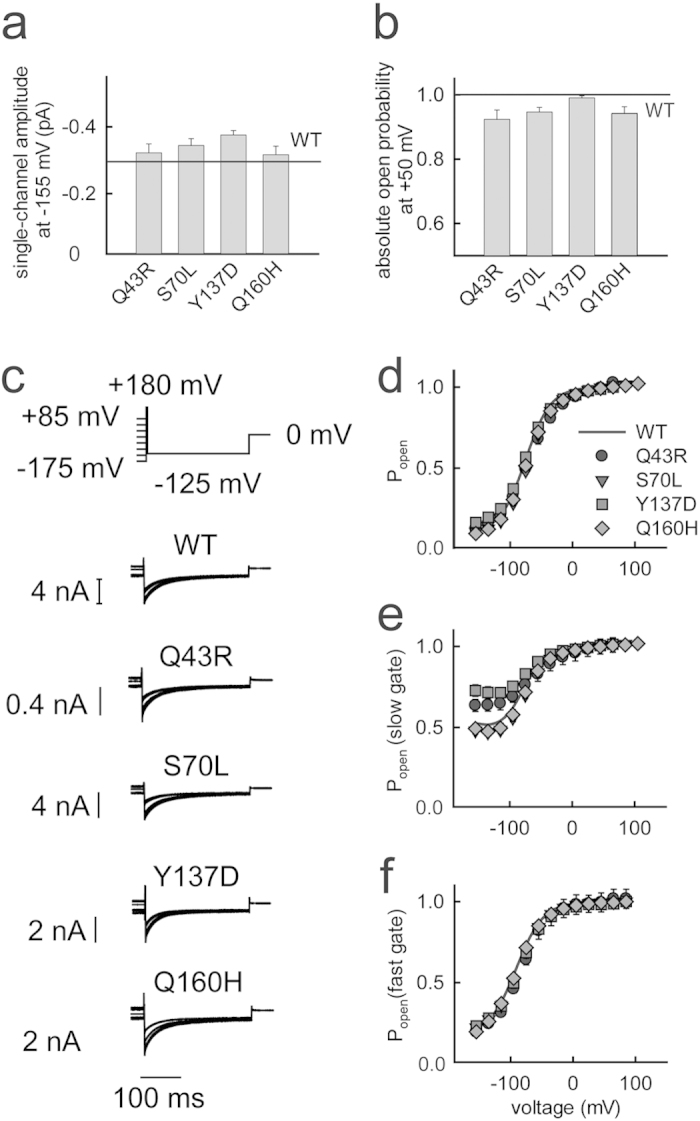
Functional properties of homodimeric mutant channels.(a,b) Mean single-channel current amplitudes at −155 mV (a) and absolute open probabilities at +55 mV (b) as obtained from non-stationary noise analysis for mutant hClC-1 (means ± SEM from 4–5 experiments). Solid lines represent WT unitary current amplitude and absolute open probability. (c) Representative tail currents from experiment to determine the voltage dependence of the slow common gate. (d) Voltage dependence of the probability of WT or mutant hClC-1 channels to be open. (e,f) Activation curves of the slow (e) and the fast (f) gate of WT or mutant hClC-1 channels (means ± SEM from 7–14 experiments).